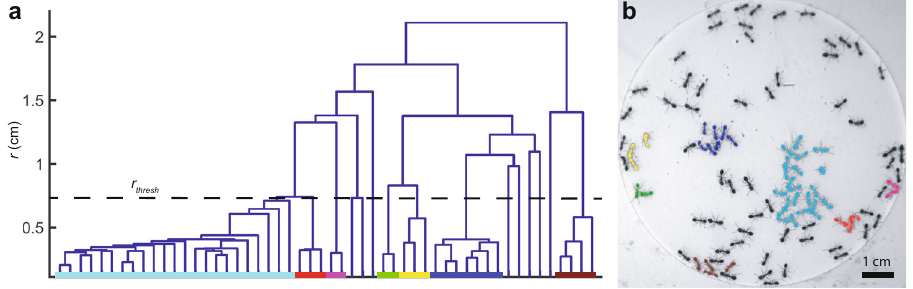
Fig. 6 | Cluster analysis. a Dendrogram for one frame of an experiment with N =100 ants. Clusters of ants correspond to branches that cross the r thresh line. Leaves that correspond to ants in a single cluster terminate on a line colored to